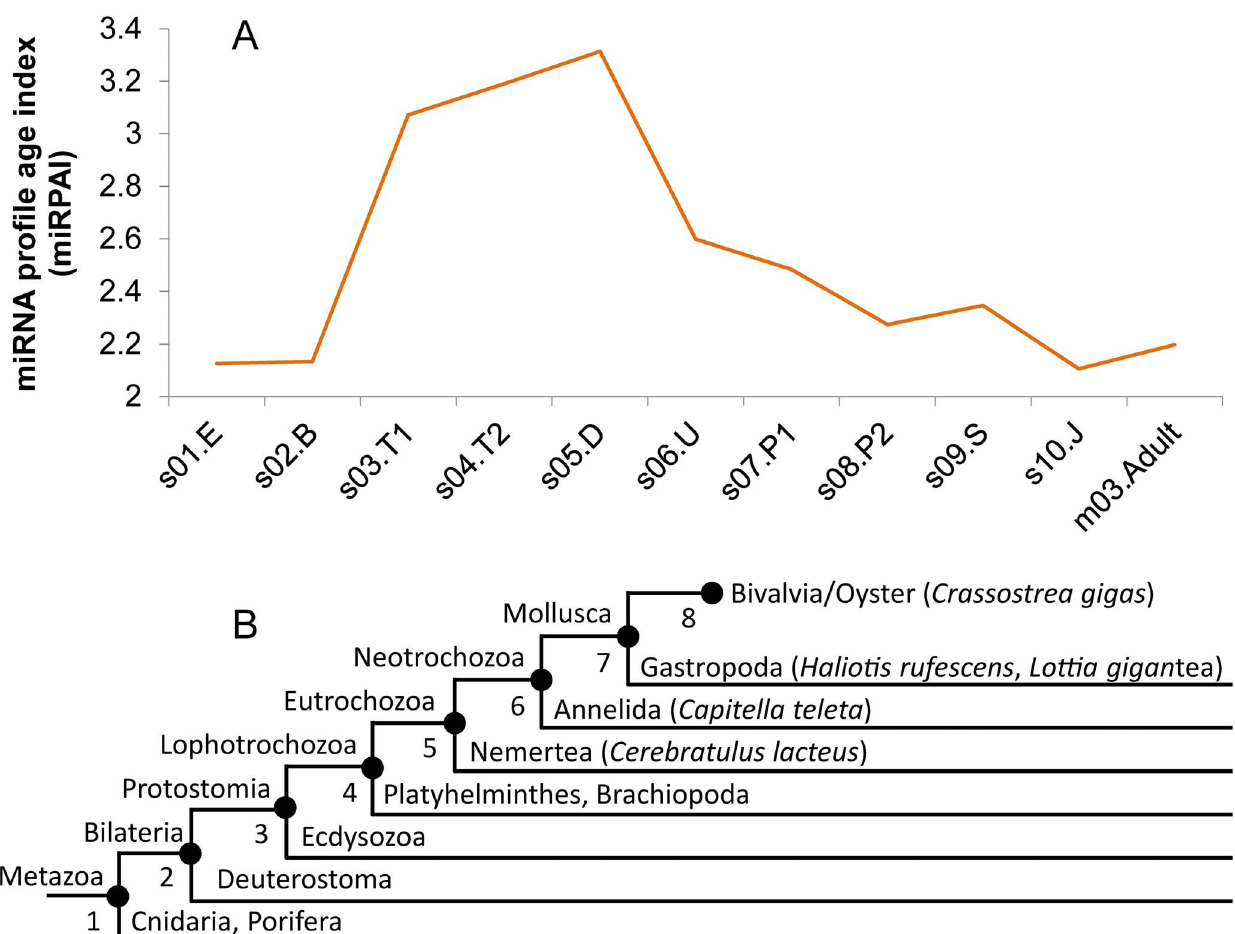
Figure 2. The miRPAI curve during oyster development. A . The miRPAIs for the 11 development stages were calculated by integrating the evolutionary acquisition (phylostrata) and the expression level of each miRNA (see the method part for details). Higher miRPAI indicates more expression of younger miRNAs in the stage. The samples are abbreviated as follows: s01.E, egg; s02.B, blastula; s03.T1, trochophore; s04.T2, trochophore; s05.D, D-shape larva; s06.U, umbo larva; s07.P1, pediveliger larva; s08.P2, pediveliger larva; s09.S, spat; s10.J, juvenile; and m03.Adult, mixture of tissues from an adult. B . The taxonomic nomenclature of the phylostrata analyses.